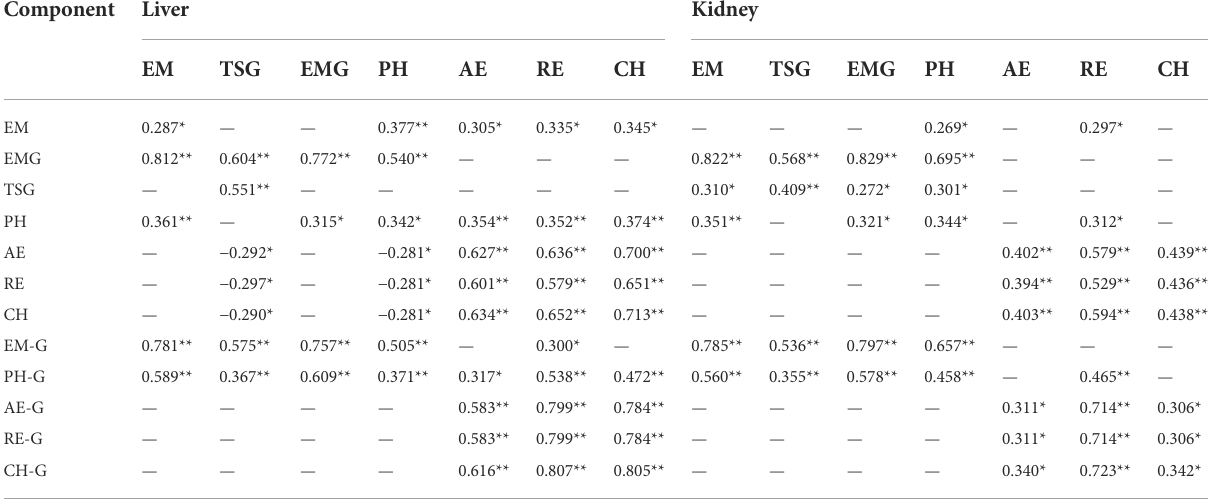
TABLE 3 Pearson correlation coef fi cients between dose level of each characteristic component of PM and rhubarb and the hepatic and renal exposure ( n = 6).